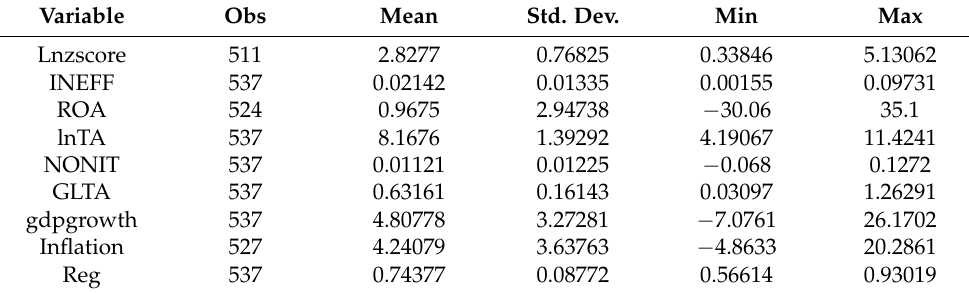
Table 3. Descriptive Statistics (Islamic Banks).